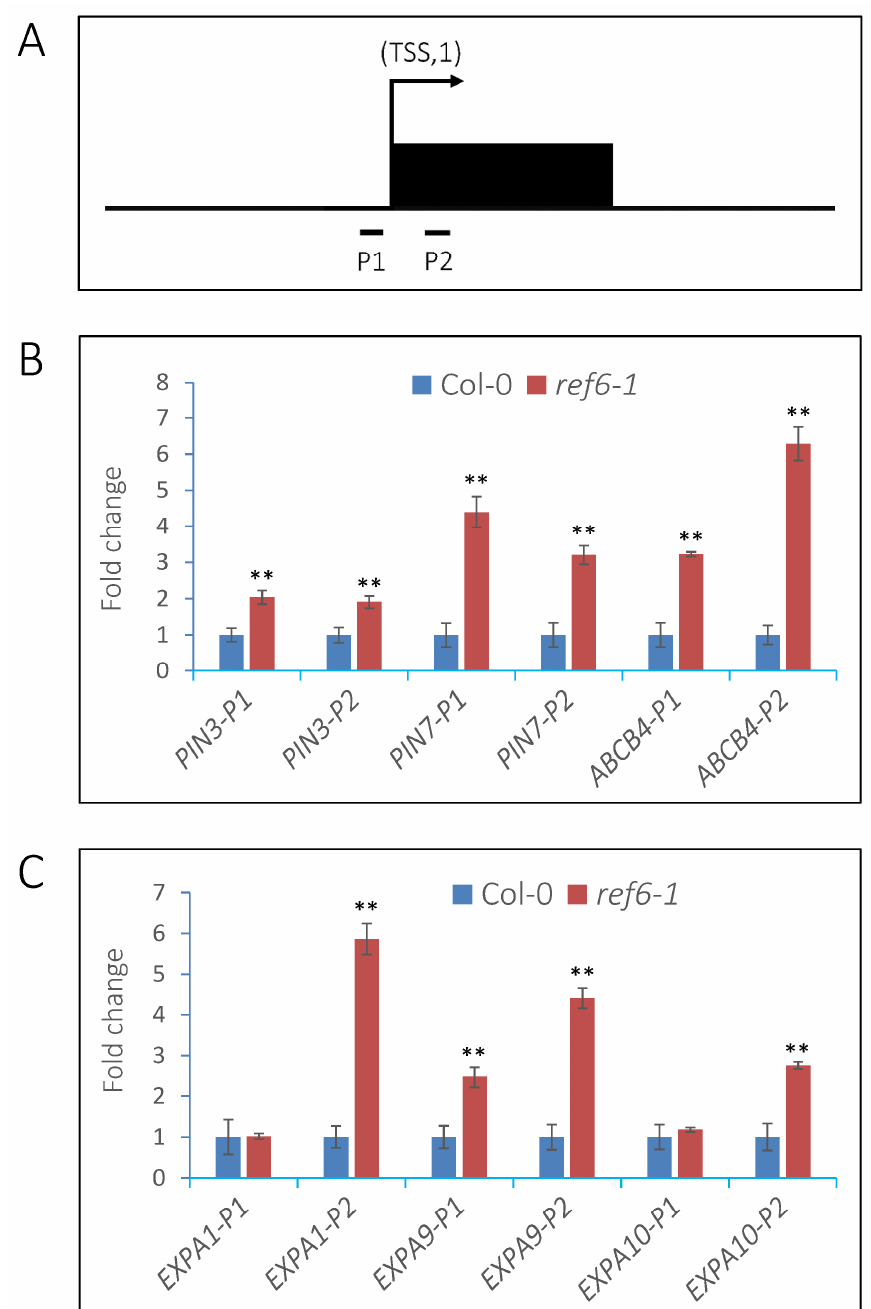
Figure 9. REF6 decreases the levels of H3K27me3 in the target genes in imbibed seeds under FR/R conditions. ( A ) Representative schematic diagram of the region for ChIP analysis. TSS indicates the transcription start site, and the black box indicates the first exon region. ( B ) ChIP-qPCR analysis of the H3K27me3 levels in auxin-signaling-related genes. ( C ) ChIP-qPCR analysis of the H3K27me3 levels of cell-wall-loosening-related genes. After FR/R treatment, seeds were kept in the dark for 24 h and then crosslinked. The chromatin was extracted, sheared to an average of 500 bp and then immunoprecipitated with anti-H3K27me3 antibody overnight. The DNA–protein complex was eluted and crosslinking was reversed. The immunoprecipitated DNA was extracted for qPCR analysis. ACTIN2 was used as an internal control. Values are shown as means ± SD ( t -test, ** p < 0.01, n =